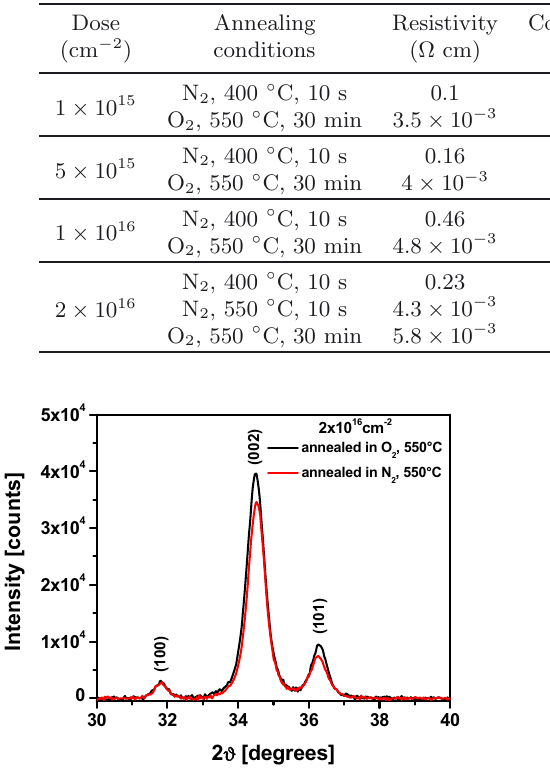
Table 1. Dependence of the properties of N-implanted ZnO:Ga films on the annealing treatment. Dose Annealing Resistivity Concentration Mobility Type Transmittance (cm − 2 ) conditions (Ω cm) (cm − 3 ) (cm 2 /V s) (%) N 2 , 400 ◦ C, 10 s 0.1 1 × 10 20 1 × 10 15